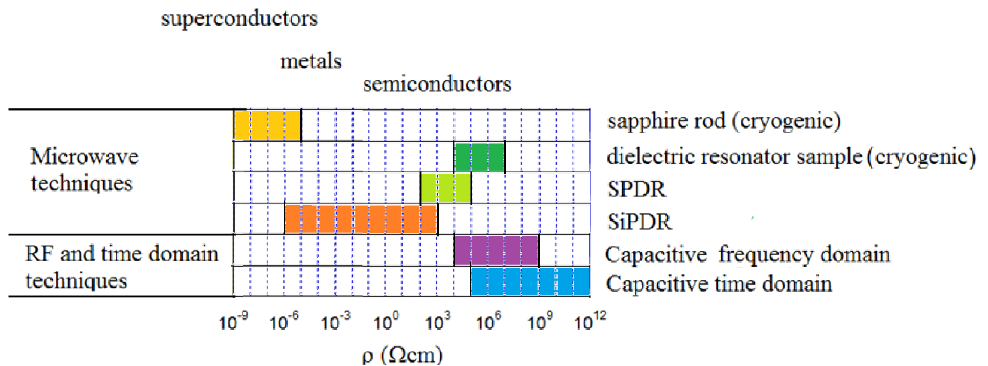
Figure 11. Resistivity ranges for contactless microwave and RF measurements methods [34]. SiPDR—single post dielectric resonator, SPDR—split post dielectric resonator.